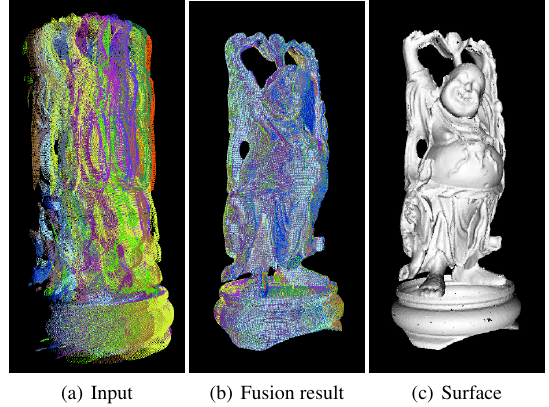
Figure 1: Point cloud